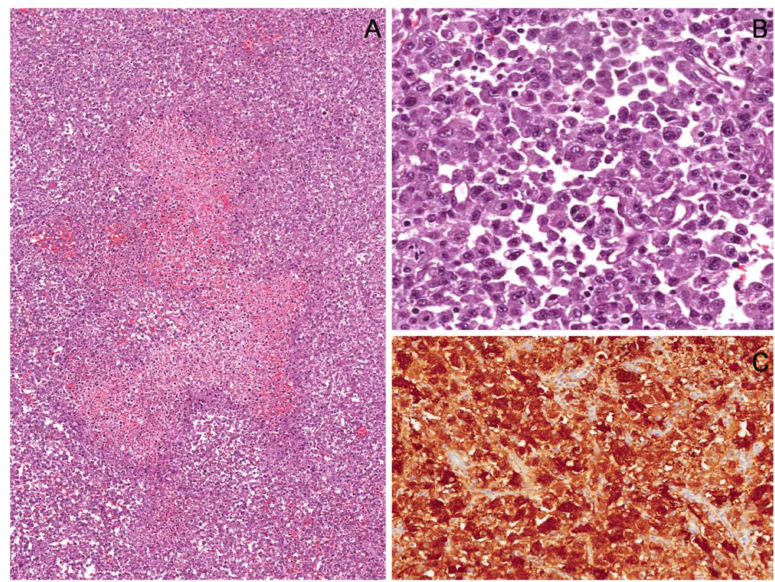
Figure 24. Epithelioid cell malignant peripheral nerve sheath tumor (MPNST). ( A ) Low-magnification image showing a hypercellular tumor with a central area of necrosis. ( B ) Tumor is composed of nests and/or cords of large-sized epithelioid cells with abundant eosinophilic to amphophilic cytoplasm and large rounded nuclei with vesicular chromatin and prominent nucleoli. ( C ) Unlike classic-type MPNST, epithelioid cell MPNST characteristically exhibits diffuse and strong immunoreactivity for S100